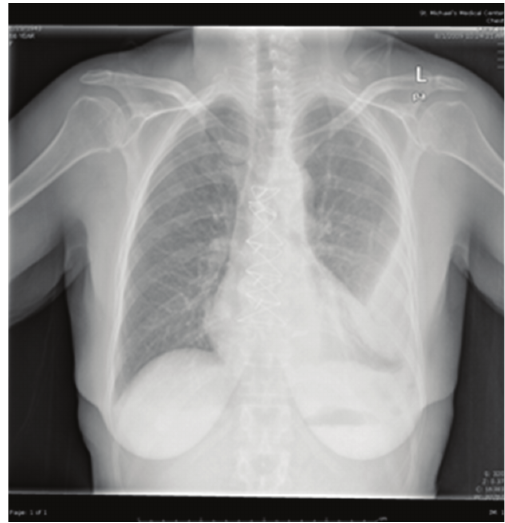
Figure 1: Posteroanterior chest X-ray view of a patient showing opacification of the lower two-thirds of the left hemithorax.